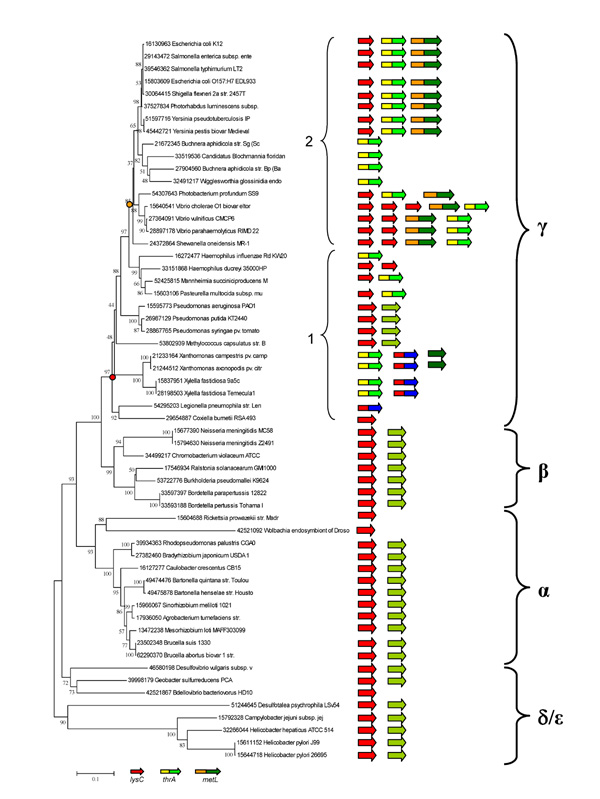
The structure of ask and hom genes. Phylogenetic tree constructed using the RpoD sequences (Neighbor Joining, 2250 Boostrap Replicates, Complete Deletion, Poisson Correction) of the 58 proteobacteria together with the number and the structure of all the retrieved ask and hom genes.